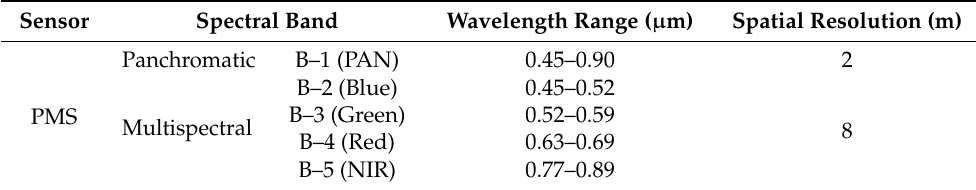
Table 2. Imagery parameters of the GF-1/PMS